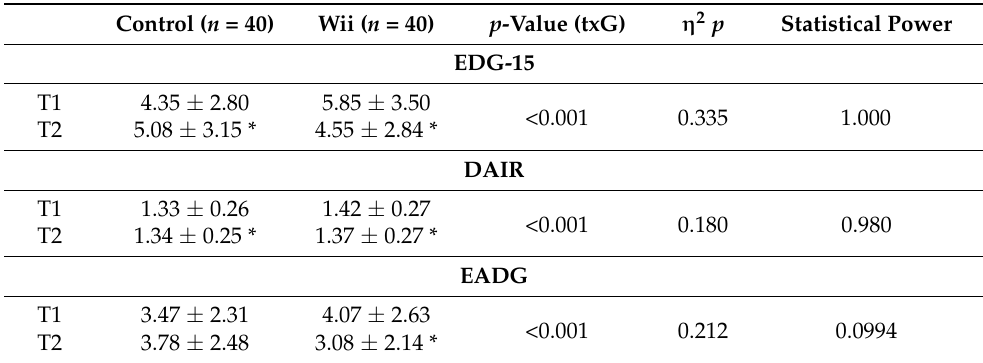
Table 4. Psychological data of the control group and Wii group before and after the intervention.